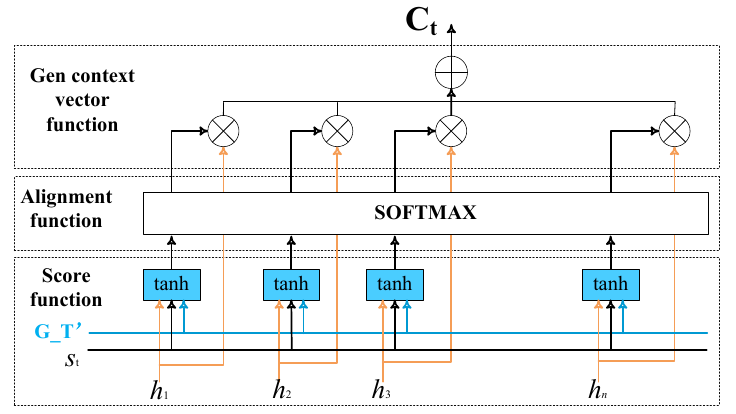
Figure 4. Global Topics with combined Attention Module.